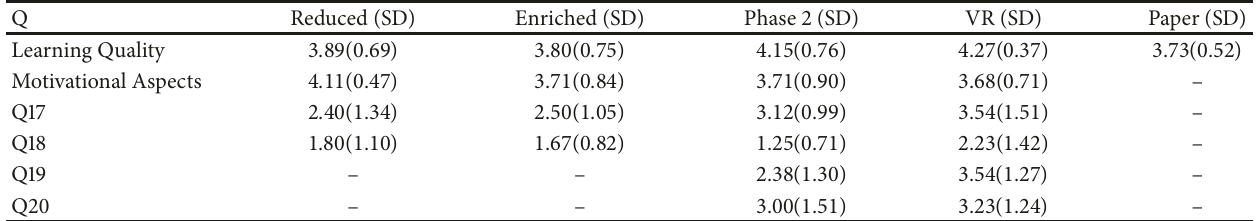
Table 4: Mean learning quality ratings (Reduced: 𝑛 = 5 , Enriched: 𝑛 = 6 , Phase 2: 𝑛 = 8 , VR: 𝑛 = 13 , and Paper: 𝑛 = 7